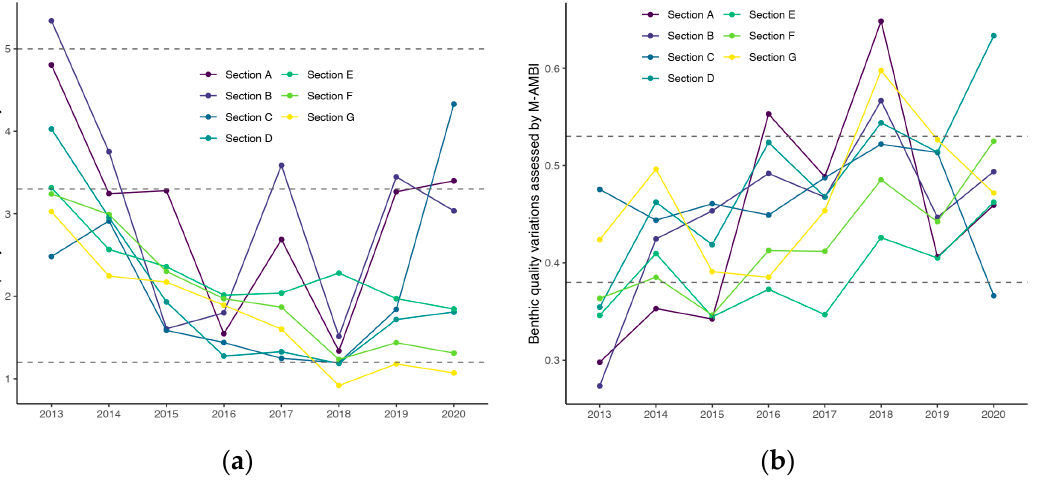
Figure 3. Benthic habitat quality variations assessed by AMBI ( a ) and M-AMBI ( b ) in seven sections of the intertidal flats in Liaohe Estuary from 2013 to 2020. Note: the threshold values for AMBI status are as follows: high = 5.0–6.0, good = 3.3–5.0, moderate = 1.2–3.3; the threshold values for